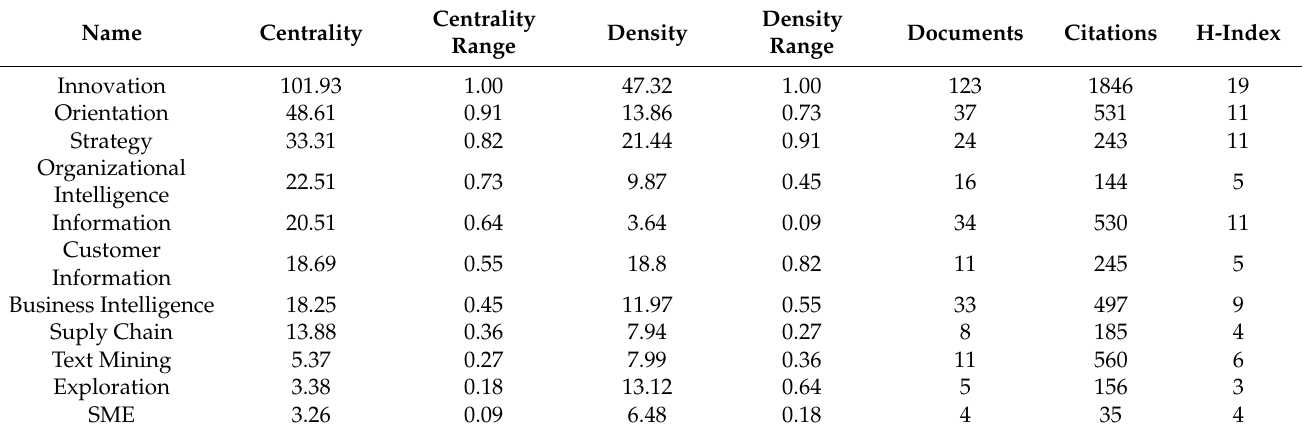
Figure 2. Strategic Map. Primary Documents period 1985–2021. Source: Prepared by the authors on the basis of SciMAT data. Table 3. Cluster period 1985–2021.